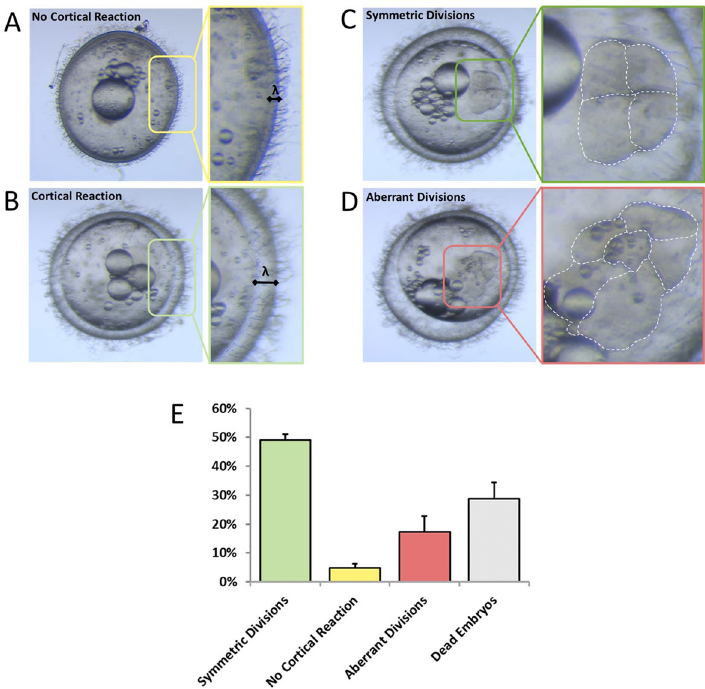
Figure 7. Cortical reaction and cell division in fertilized and unfertilized eggs. ( A ) Oocytes that do not undergo the cortical reaction display closely apposed chorion membrane and yolk (λ represents the average distance of 35.0 ± 10.6 µm, N = 8). ( B ) Embryo in which the cortical reaction has occurred properly (λ represents the average distance, of 87.6 ± 11.2 µm, N = 14). ( C ) Embryo undergoing correct cell division at the 4 cell stage. ( D ) Pseudoembryo undergoing aberrant divisions. ( E ) Average embryonic phenotypic distribution. N = 4 independent natural fertilizations with 470, 332, 101, 612 eggs collected, respectively. The graph represents the average of the 4 different